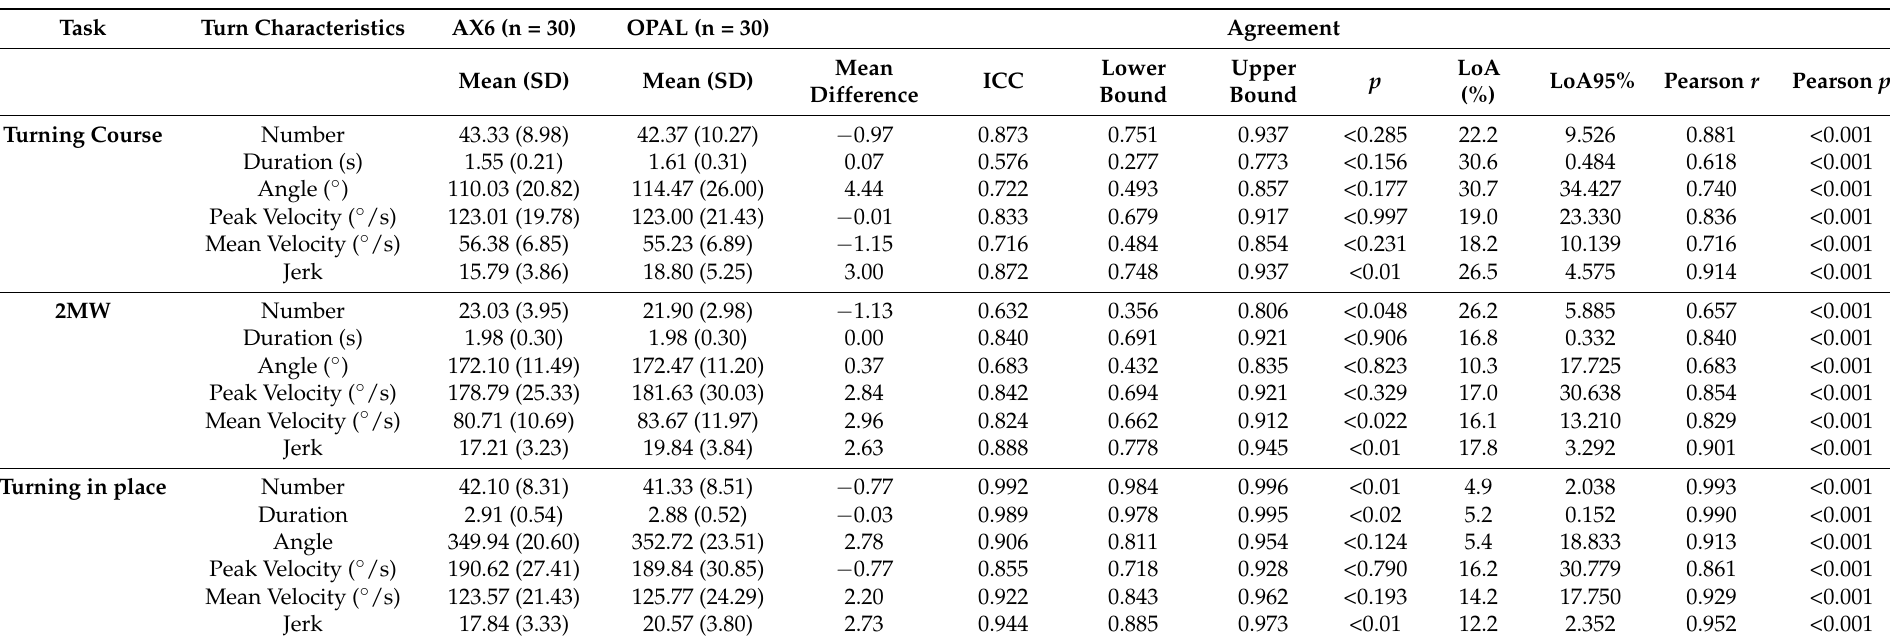
Table 2. Mean difference, ICC 2.1 , mean difference ( p ), limits of agreement (LOA%), and Pearson correlation between OPAL and AX6 sensors for turning characteristics for three turns